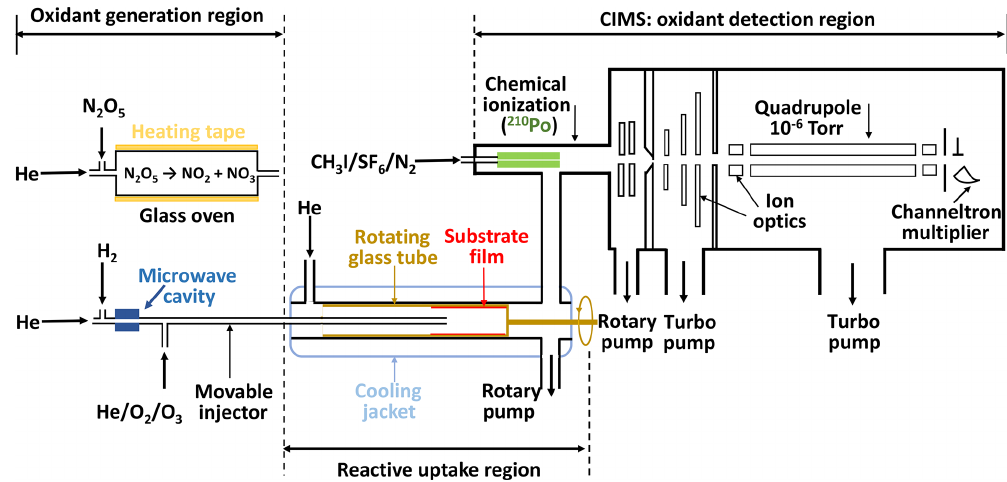
Figure 1. Schematic of the low-temperature coated-wall flow reactor coupled to the chemical ionization mass spectrometer (CIMS). The oxidant generation region displays the generation methods for NO 3 and OH